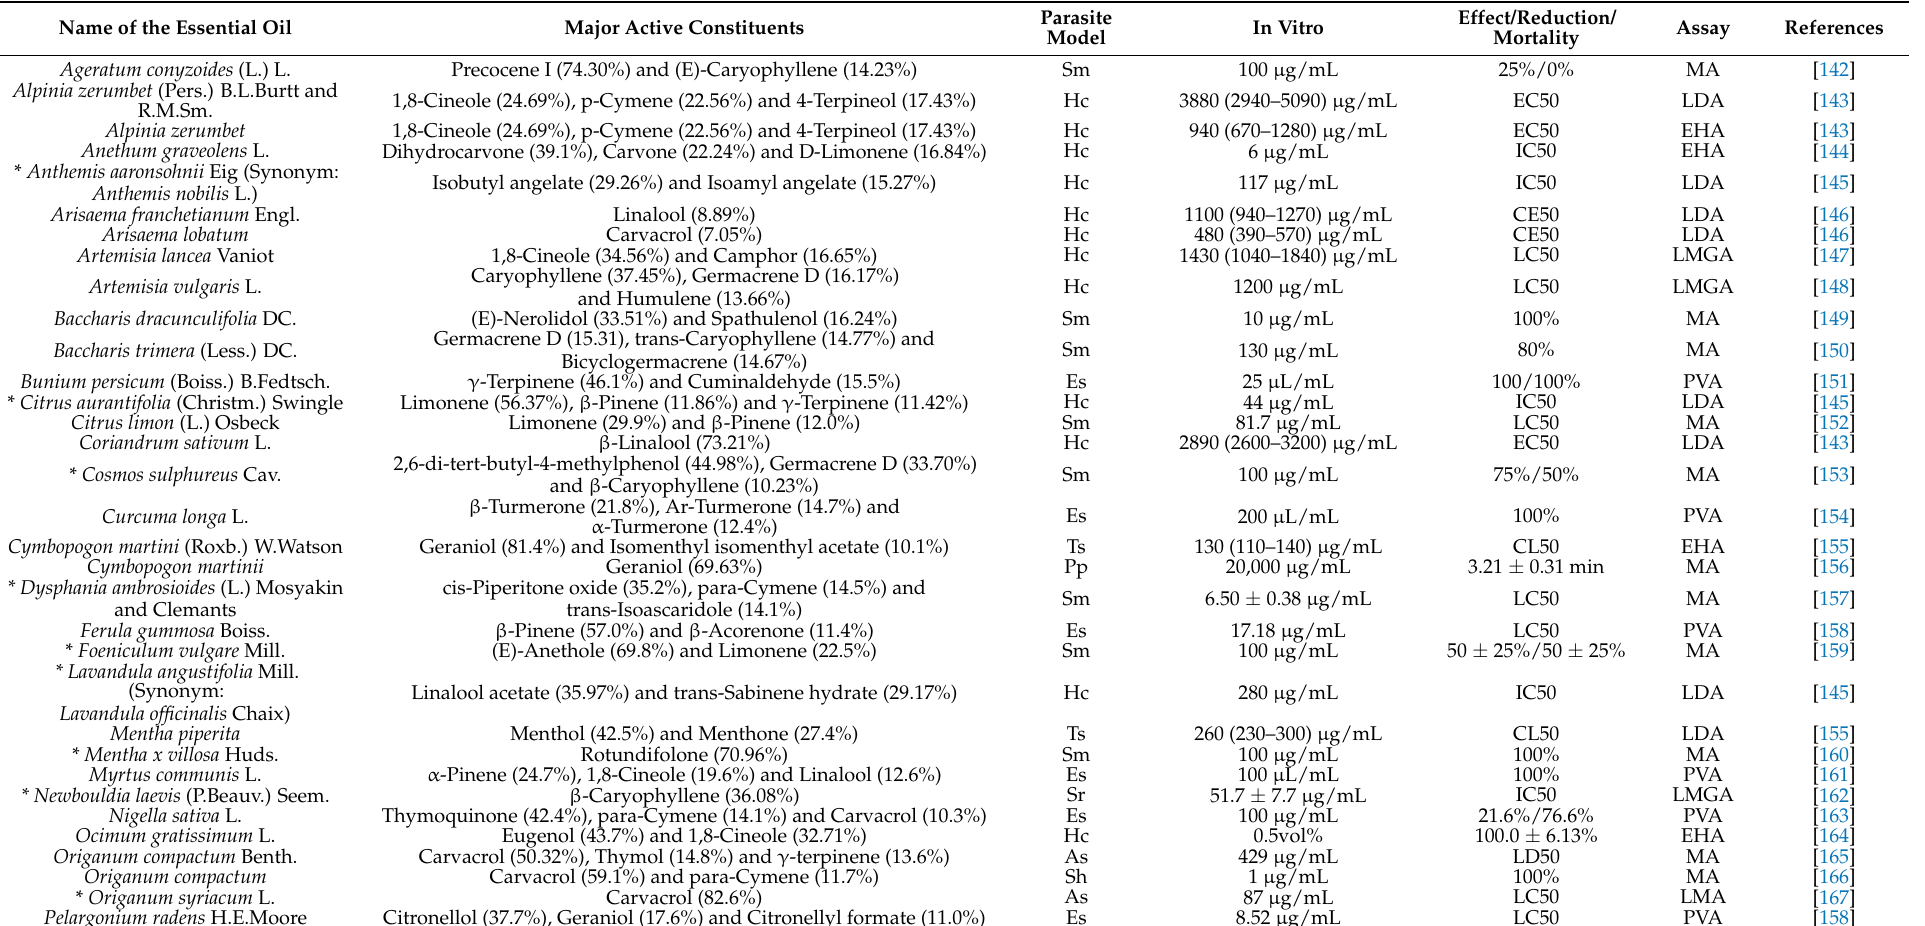
Table 2. List of selected essential oils and their major constituents with in vitro activity that were not studied so far with in vivo models (for an expanded list, see Supplementary